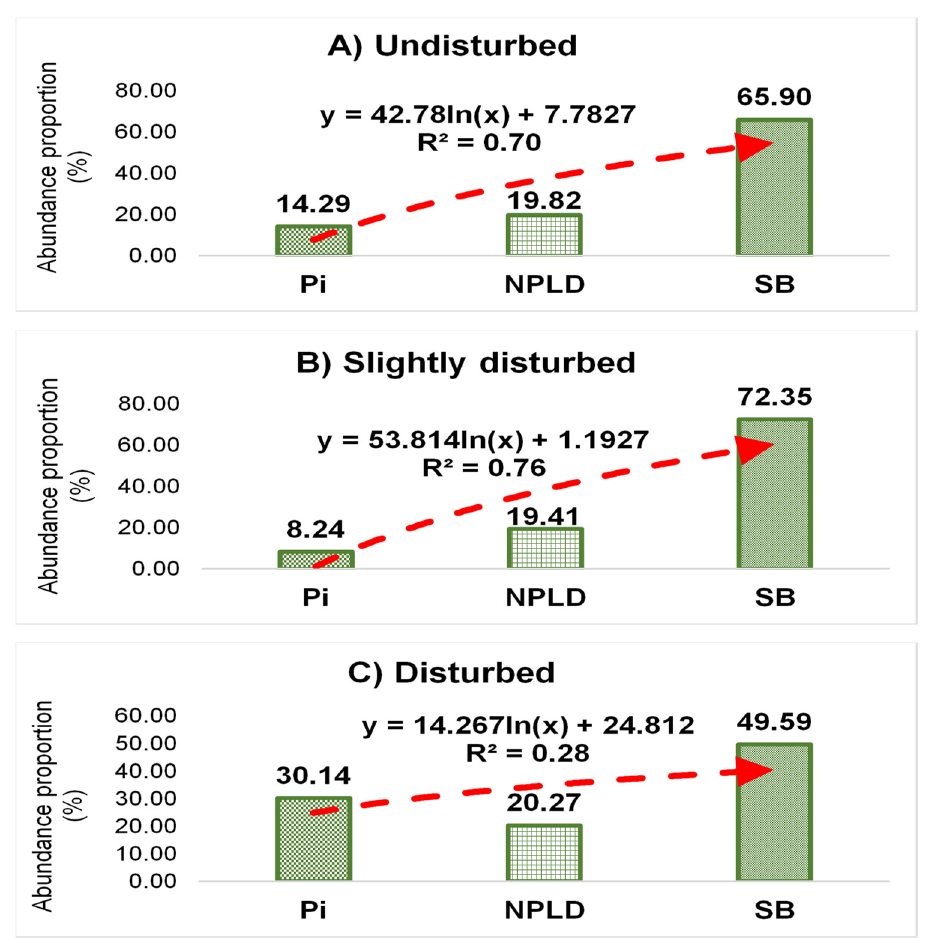
Figure 2. Ecological regeneration shift of tree species in gap regeneration under different forest areas ( A – C ). Pi—Pioneers, NPLD—Nonpioneer light-demanding species and SB—Shade bearers. Source: authors construct [2020].